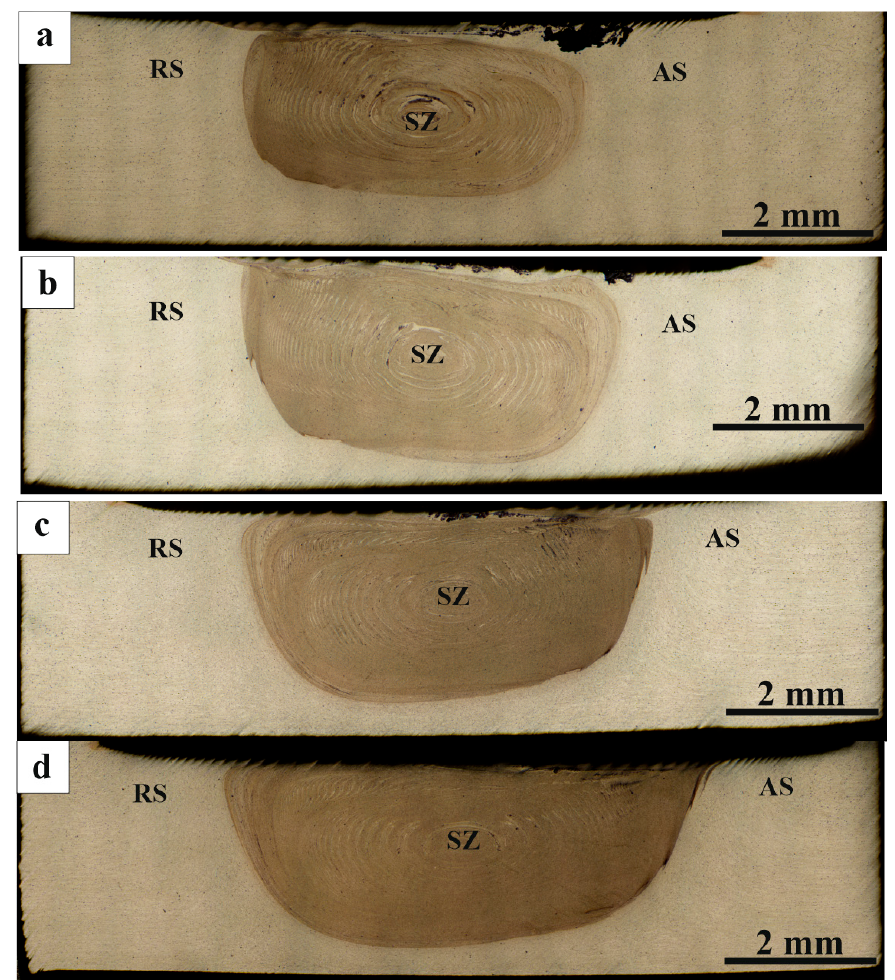
Figure 5. Macrostructure of RPPs/AA5056 composite after: ( a ) 1st; ( b ) 2nd; ( c ) 3rd; and ( d ) 4th additional tool passes along the machining line. SZ—stir zone; RS—retreating side; AS—advancing side.